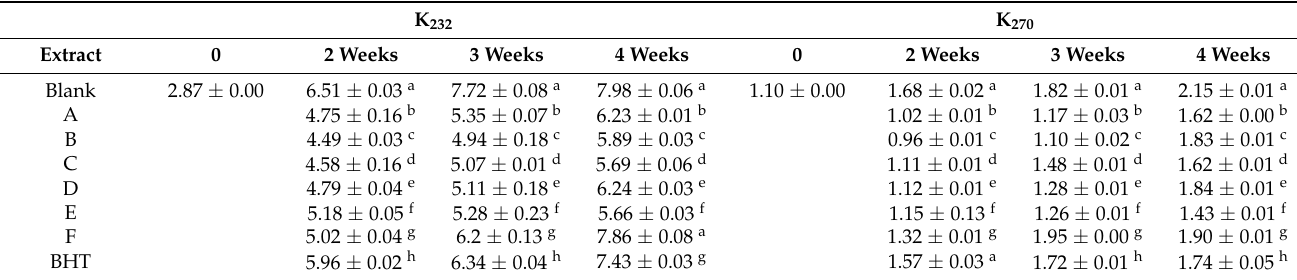
Table 3. K 232 and K 270 values of sunflower oil samples enriched with OOD extracts obtained by Method 3. K 232 K